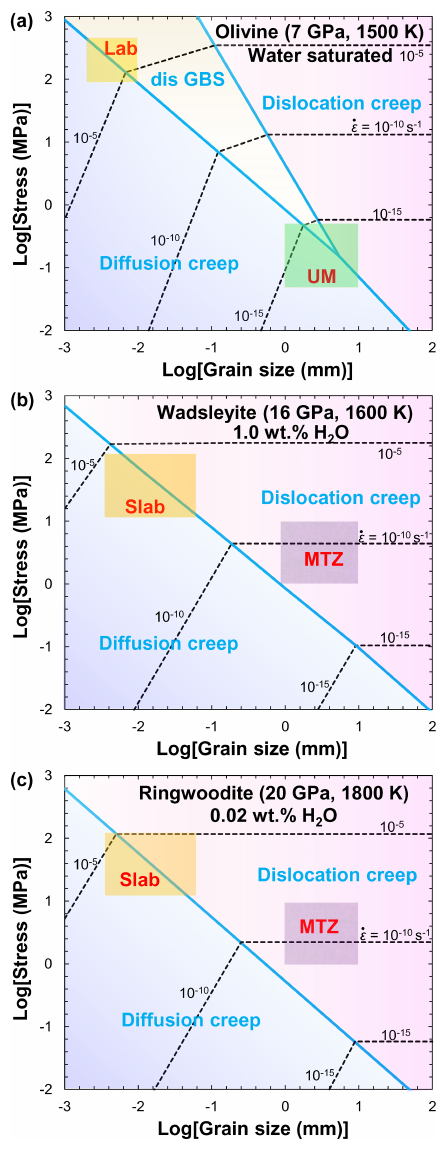
Figure 19. Grain-size/stress-deformation mechanism maps for (a) (Mg 0 . 9 Fe 0 . 1 ) 2 SiO 4 olivine ( P = 7GPa, T = 1500K, and water-saturated conditions), (b) (Mg 0 . 9 Fe 0 . 1 ) 2 SiO 4 wadsleyite = 1 . 0wt.% H ( P = 16GPa, T = 1600K, and C H 2 O) and 2 O (c) (Mg 0 . 9 Fe 0 . 1 ) 2 SiO 4 ringwoodite ( P = 20GPa, T = 1800K, and = 0 . 02wt.% H C H 2 O). The power-law creep constitutive rela- 2 O tions in olivine were established by Mei and Kohlstedt (2000a, b) and Hirth and Kohlstedt (2003) and in wadsleyite and ringwood- ite calculated from the Si diffusion data (Shimojuku et al., 2009, 2010; Druzhbin, 2019) using Eqs. (14)–(17) with l g /l c = 1. Note that dis GBS represents dislocation grain-boundary sliding. The thick light blue lines represent boundaries between different creep mechanisms. The orange, green, and dark purple boxes show the possible variations of grain size and stress in the laboratory, UM, MTZ and the subducting slabs,